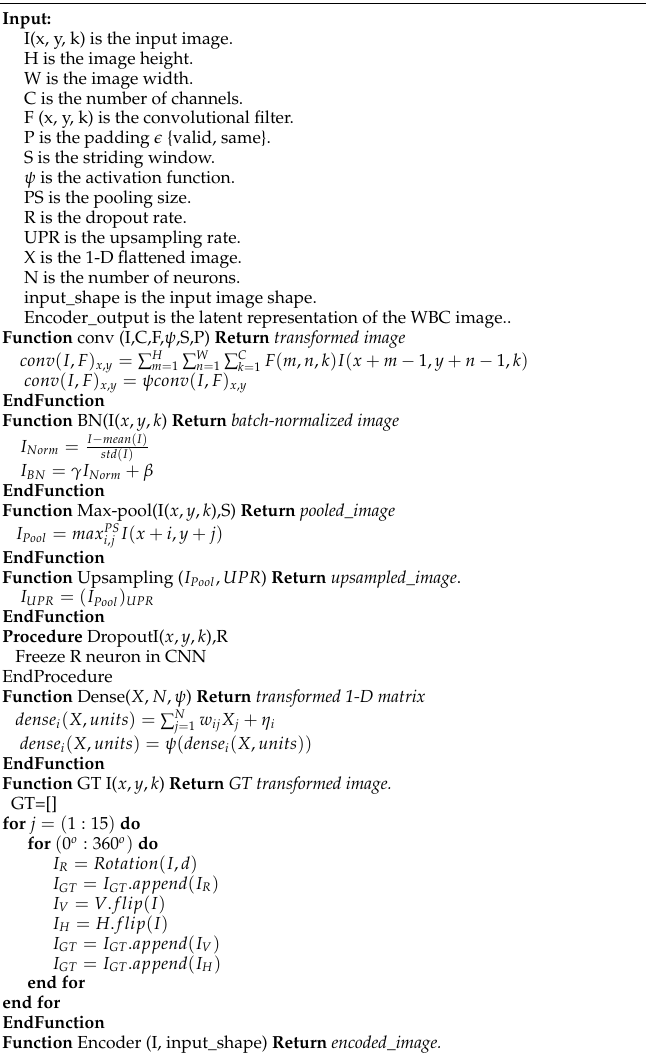
Algorithm 1 The GT-DCAE WBC augmentation